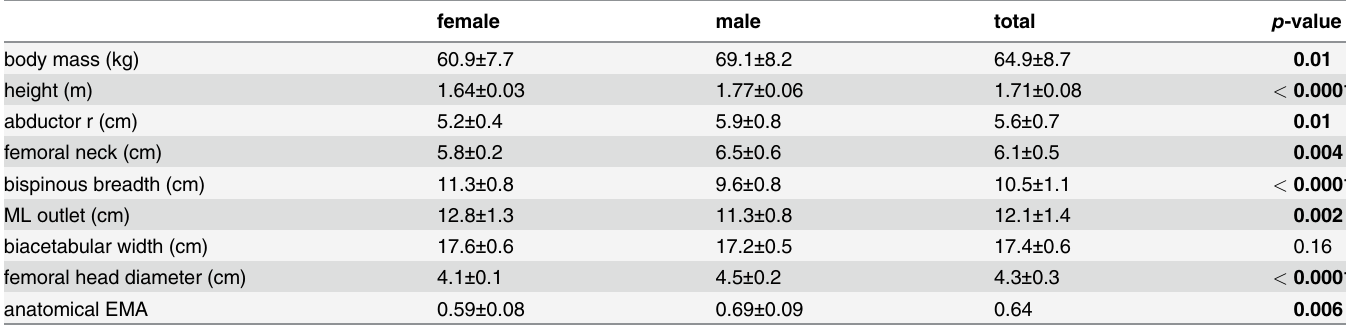
Table 1. Summary statistics for anthropometric